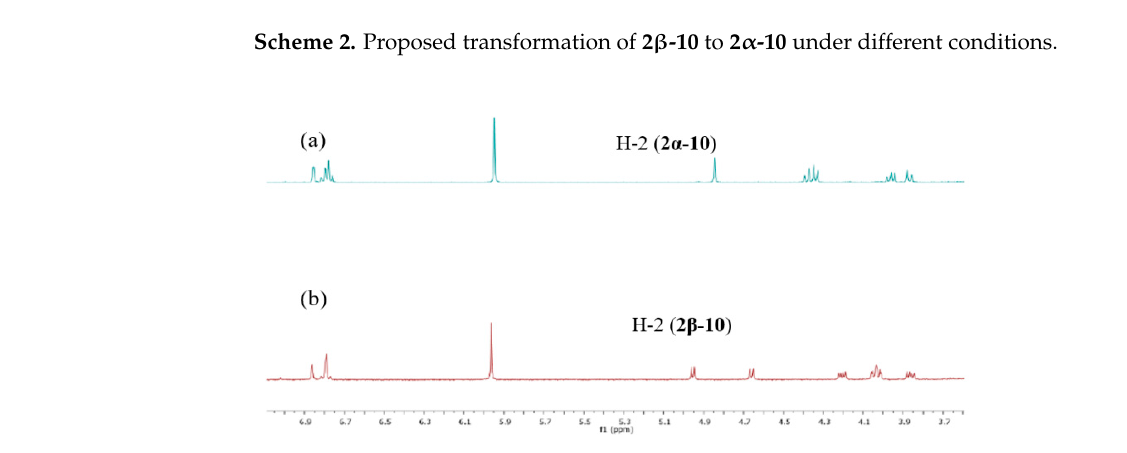
Scheme 2. Proposed transformation of 2 β -10 to 2 α -10 under different conditions.